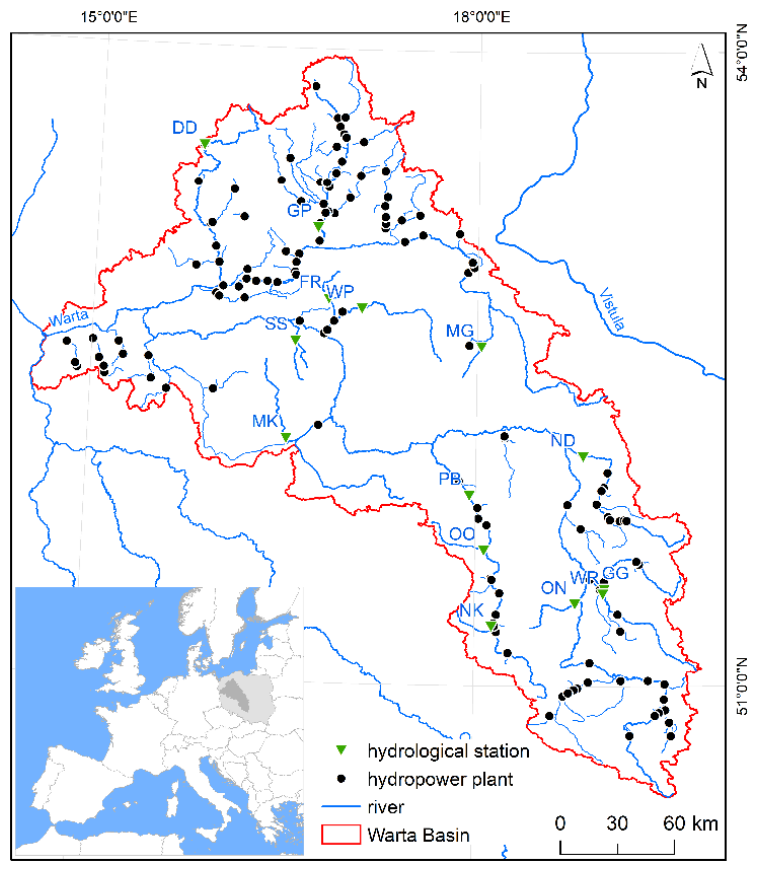
Figure 1. Study site location. Table 1. Hydrological